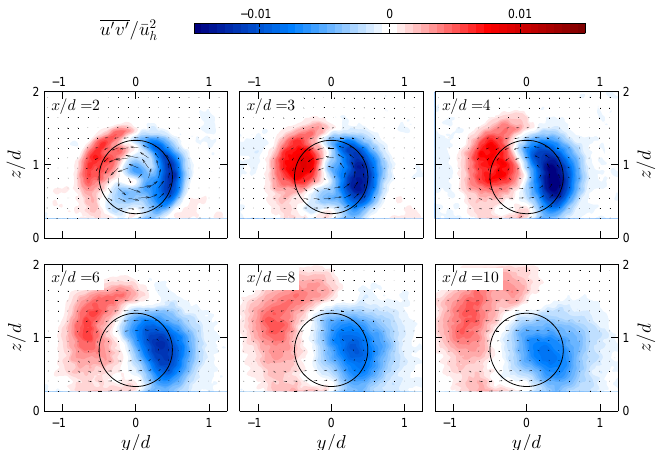
Figure 8. Contours of the normalized lateral momentum turbulent flux u (cid:48) v (cid:48) / ¯ u 2 downstream locations for the miniature turbine operating at λ = λ o . The vector field represents the in-plane velocity components. The black circles show the frontal area of the wind